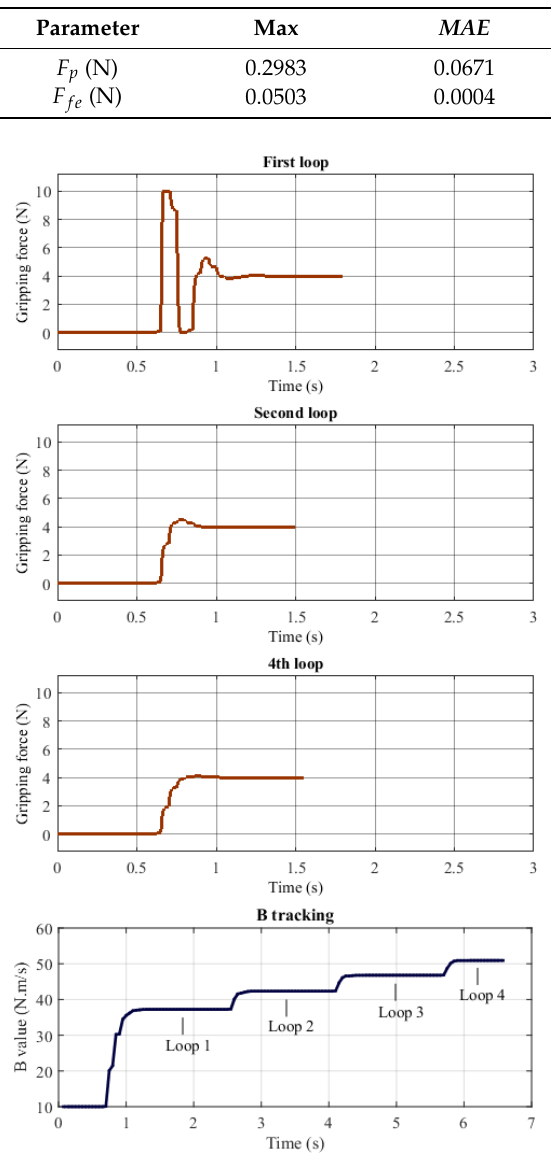
Figure 7. The tracking force and B value through several loops in simulation.